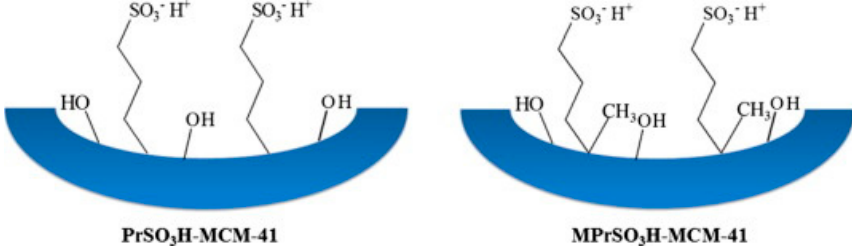
Figure 11 . Structure of PrSO 3 H-MCM-41 and MPrSO 3 H-MCM-41. Reproduced with permission from [18]. Copyright 2016 Elsevier